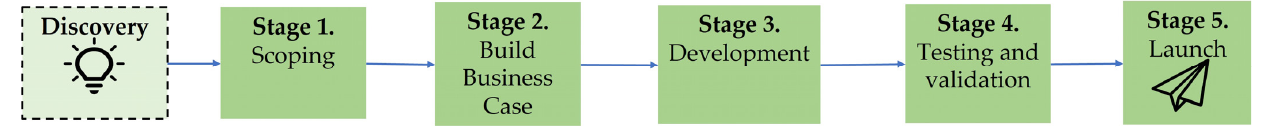
Figure 1. The Stage-gate progress, own illustration, adapted from Cooper [26].